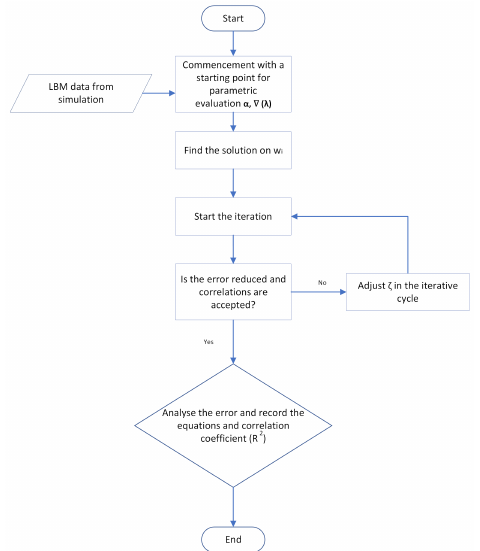
Figure 2. Flowchart of LM algorithm using LBM data for the correlation